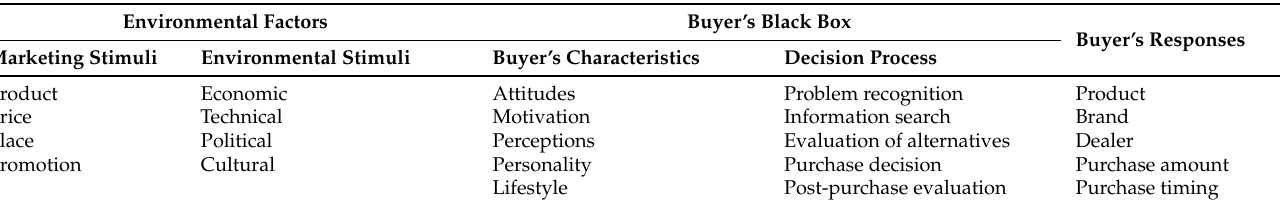
Table 2. The black box model in